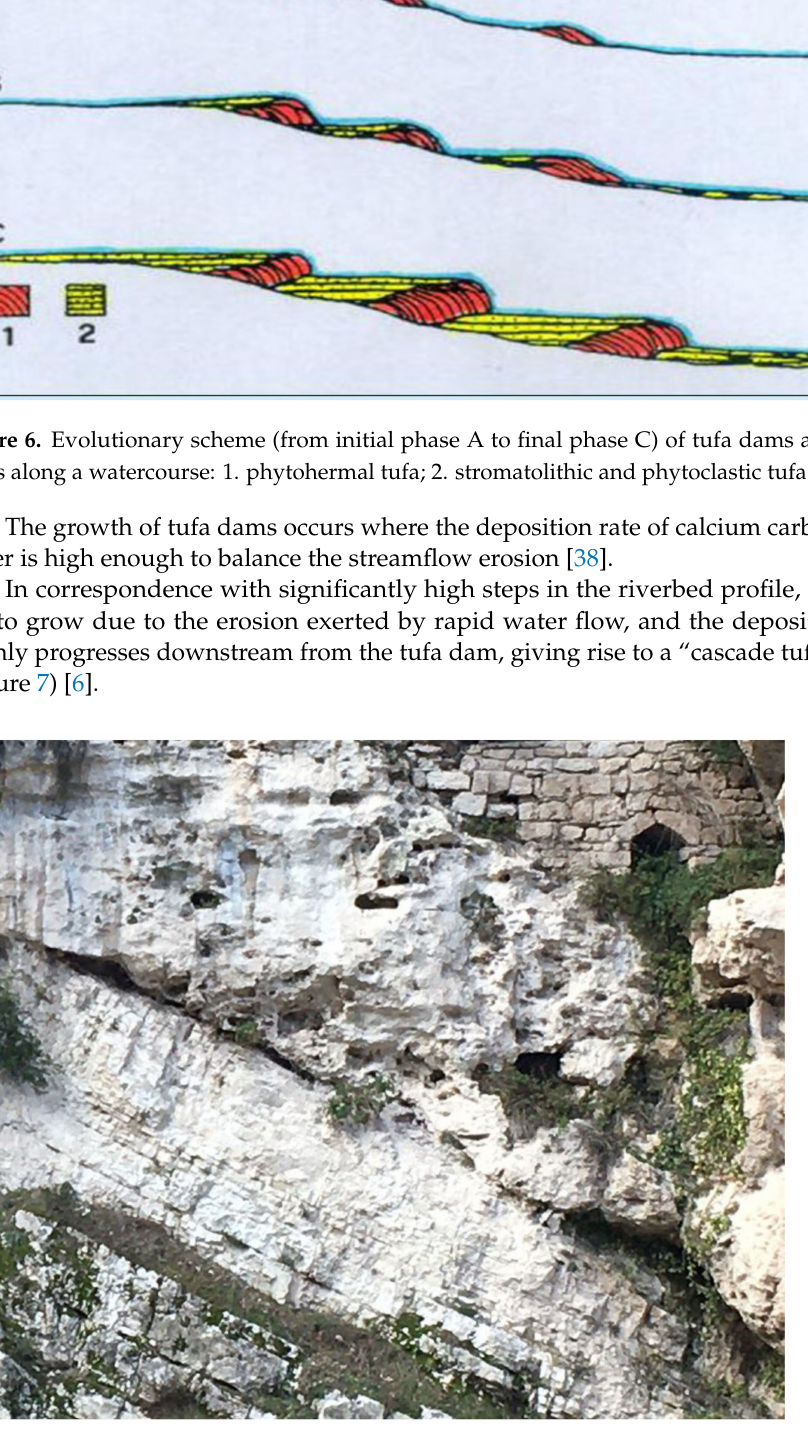
Figure 7. Cascade tufa overlying Mesozoic limestone in the upper Esino River basin (Central